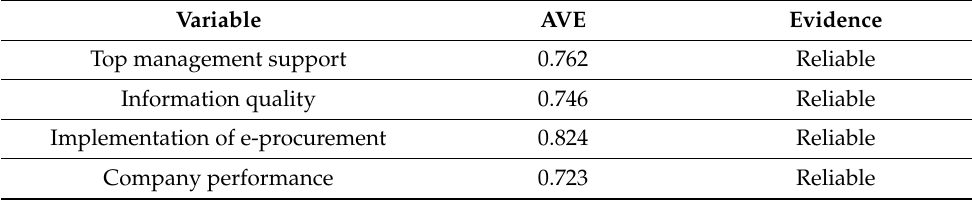
Table 6. Results of Average Variance Extracted (AVE) value.